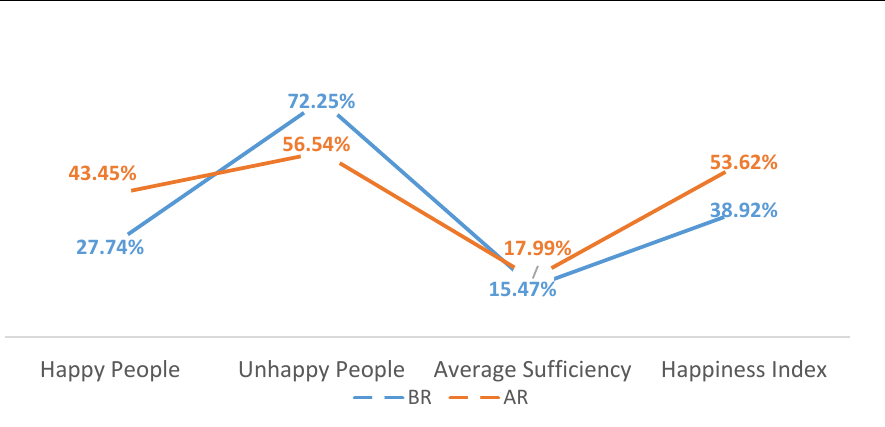
Figure 2. Comparison of happiness indices BR (Before Rehabilitation), AR (After Rehabilitation). Source: Compiled by the researchers.